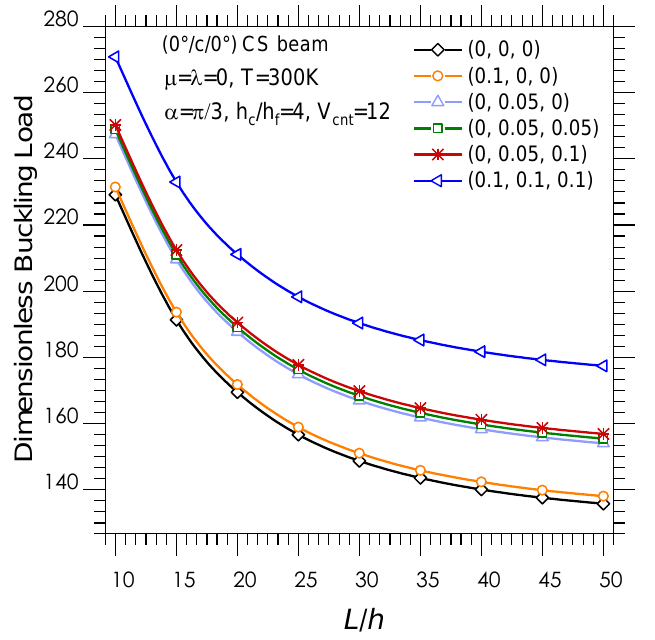
Figure 9. Effect of thickness ratio and elastic foundation on the dimensionless buckling load.